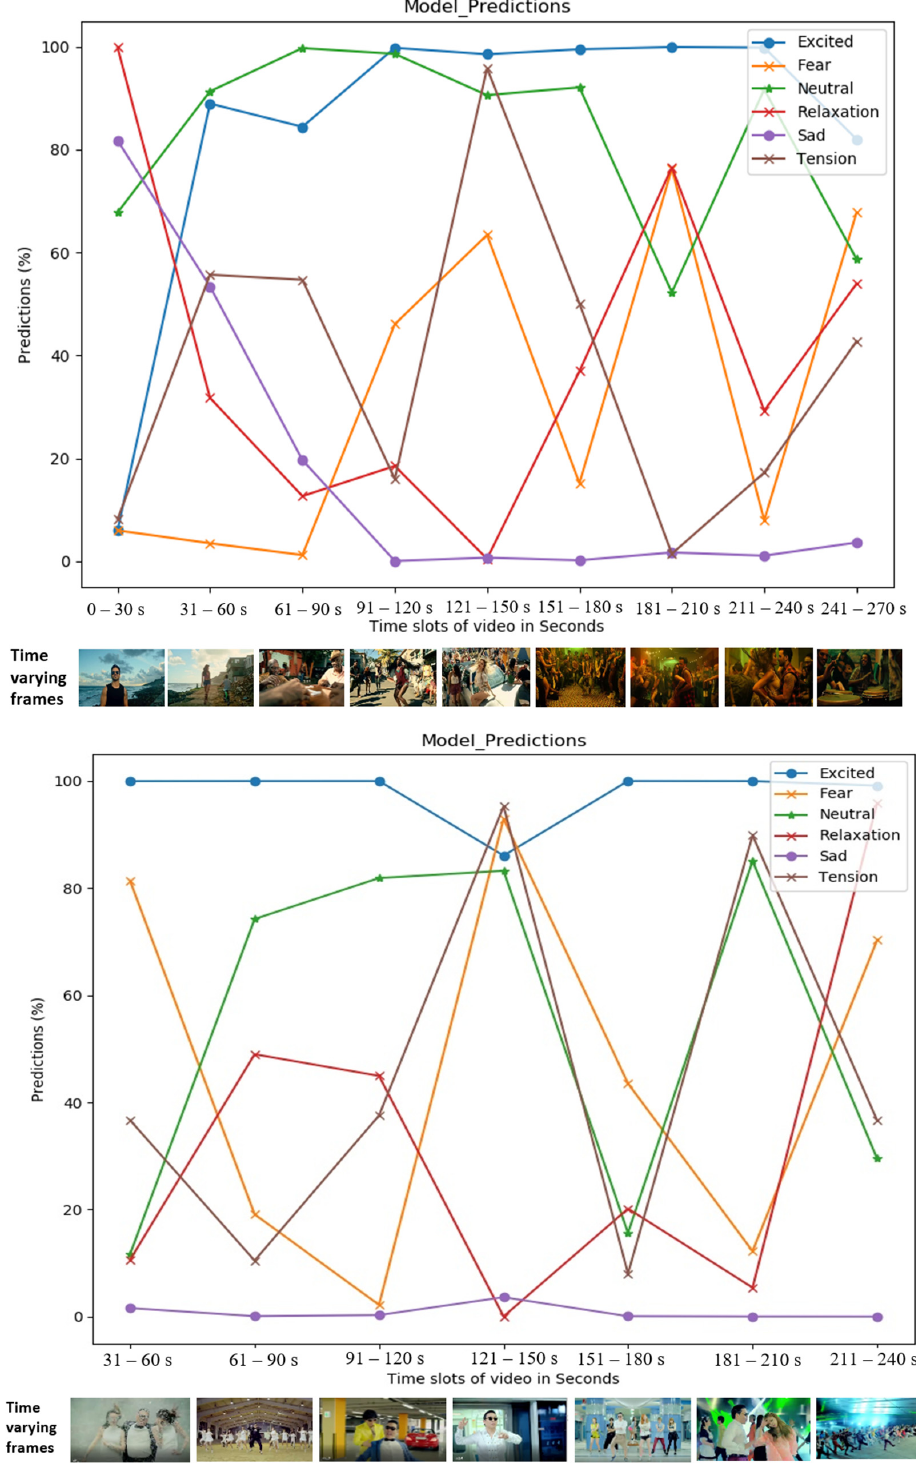
Figure 7. Time-synchronized emotional predictions for specific music videos. Prediction results for the Luis_Fonsi ( top ) and Gangnam Style ( bottom ) music videos.